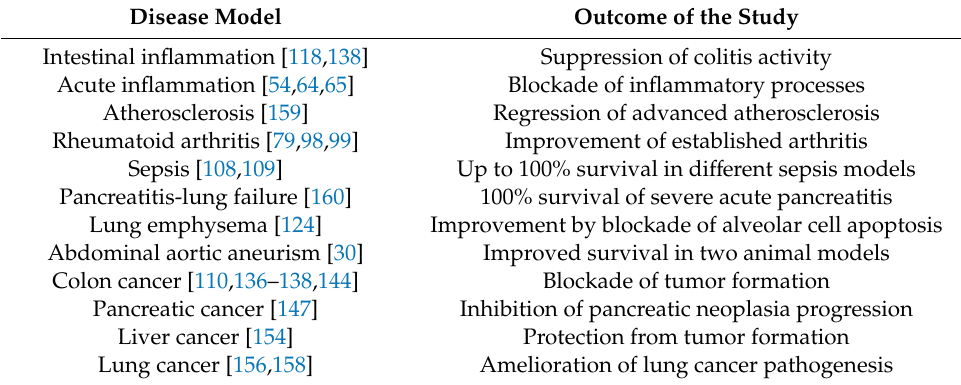
Table 1. E ffi cacy of IL-6 trans-signaling blockade by sgp130Fc in preclinical models of inflammation and inflammation associated